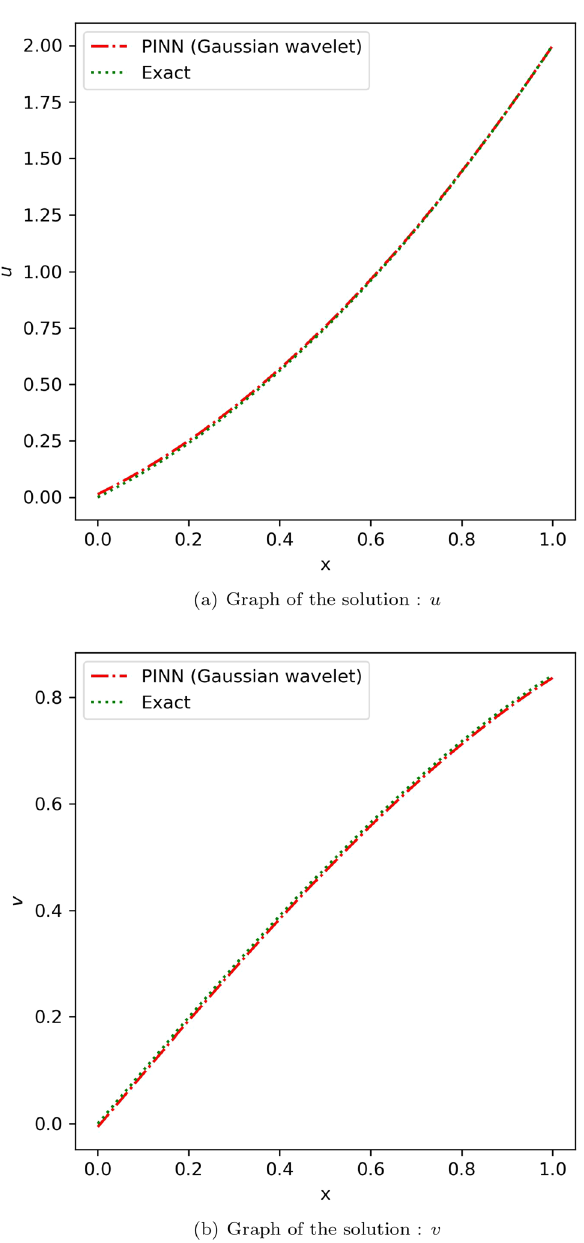
Figure 10. Comparison of the results of proposed method using Gaussian wavelet with the exact solution for the linear coupled